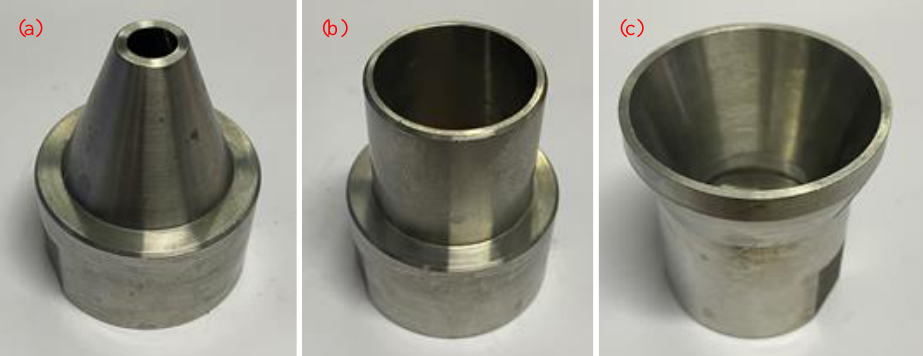
Figure 2. The picture of the convergent nozzle, the straight nozzle, and the expanding nozzle: ( a ) ShrinkingN20, ( b ) StraightN0, and ( c ) ExpandingN20.